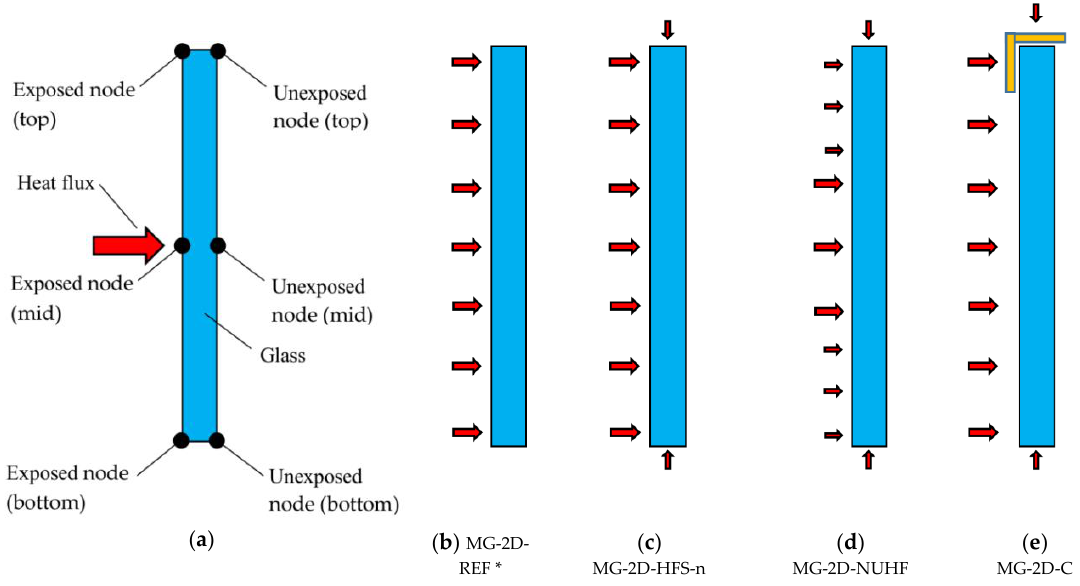
Figure 6. Schematic representation (front view) of 2D heat transfer models (ABAQUS): ( a ) location of the reference control points for the thermal performance assessment, with ( b – e ) different boundary and loading configurations for the FE parametric study. * = reference 2D model for the parametric study. Table 3. Input properties for the 2D parametric models (ABAQUS).